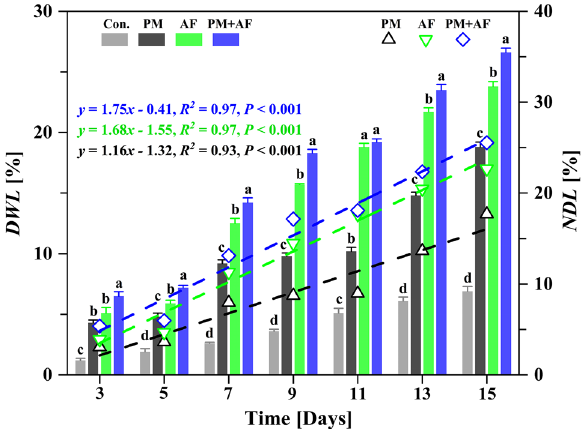
Figure 1. The changes in degradation weight loss ( DWL ) and net degradation loss ( NDL , the difference in the DWL value between the inoculation experiment and the uninoculated control) for garden biomass during the 15-day experiments, with measurements at 2-day intervals. The equations and dashed lines represent the linear fit of the NDL over the 15-day experiments. Experiments: Con., uninoculated control; PM, Pseudomonas mandelii ; AF, Aspergillus fumigatus ; PM + AF, co-culture of the two microbes. Bars on a given date labelled with different letters differ significantly ( P < 0.05) between the four